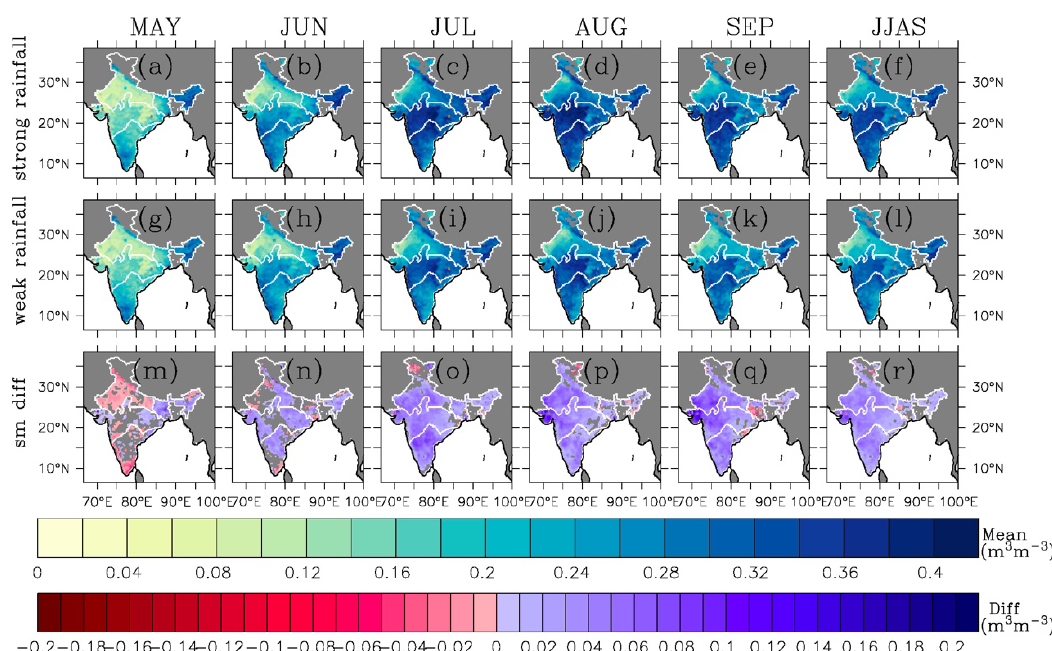
Figure 4. Spatial variations in monthly mean soil moisture for May through September and JJAS-mean rainfall for strong ISMs ( top row , ( a – f )), weak ISMs ( second row , ( g – l )), and its difference (strong ISMs minus weak ISMs) ( bottom row , ( m – r )). The difference is shown only when it is statistically significant at a 95% confidence level. The unit for daily volumetric soil moisture is m 3 m − 3 . The borders between the IMD regions are shown in white.